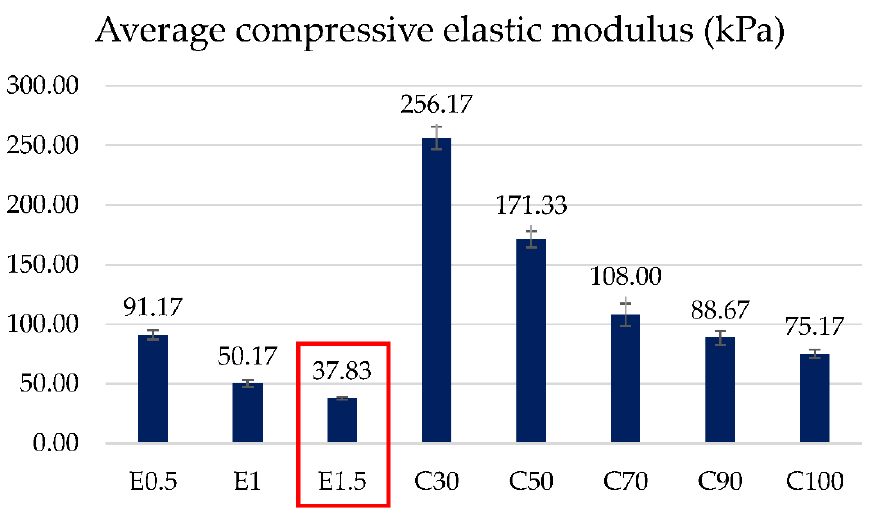
Figure 1. Compressive elastic modulus of the different groups tested with the preliminary selection to simulate the brain.